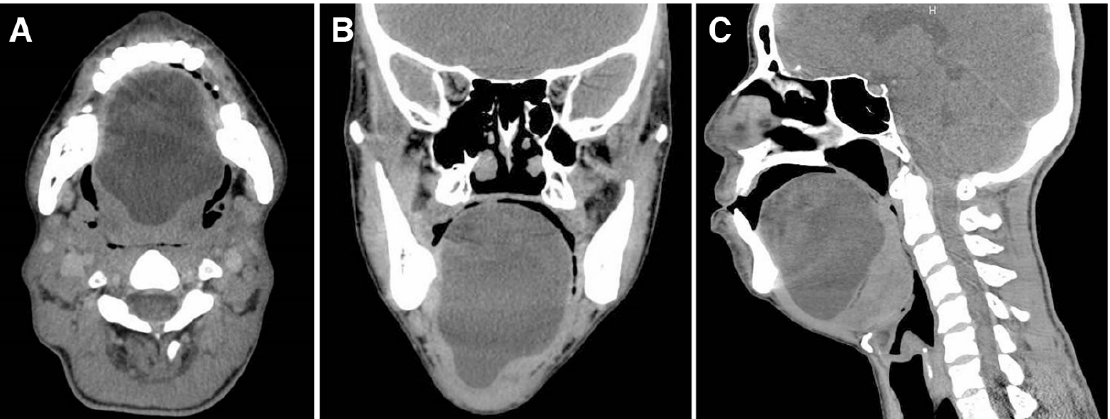
Figure 2. CT findings. ( A – C ) A well-defined cystic lesion with a maximum diameter of 75 mm was found on the mylohyoid muscle.